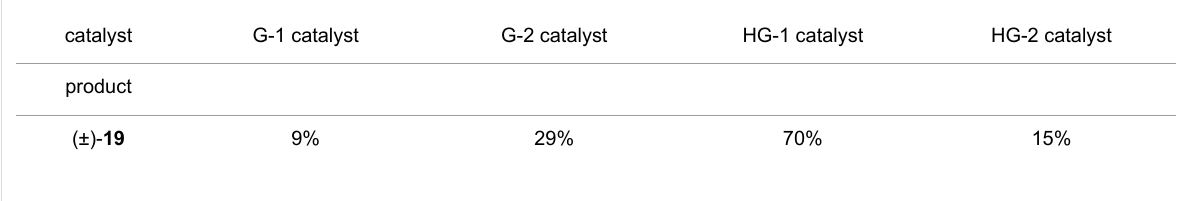
Table 5: Isolated yields for compound (±)- 19 formed in the ring-opening reaction of lactam (±)- 18 with ethylene in ROM reactions with various cata-